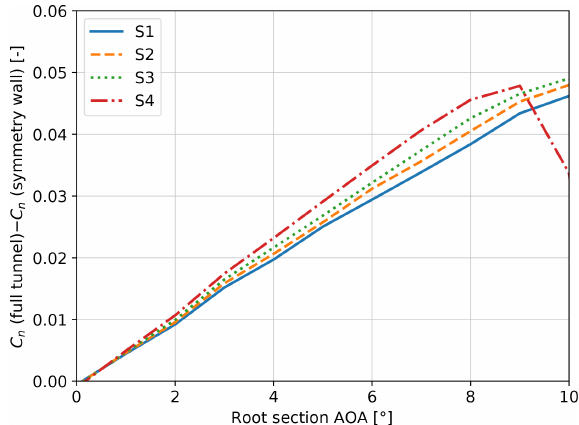
Figure 11. The difference in C n between the full-tunnel configura- tion and the symmetry wall condition. Computed by the LLTunnel code using clean